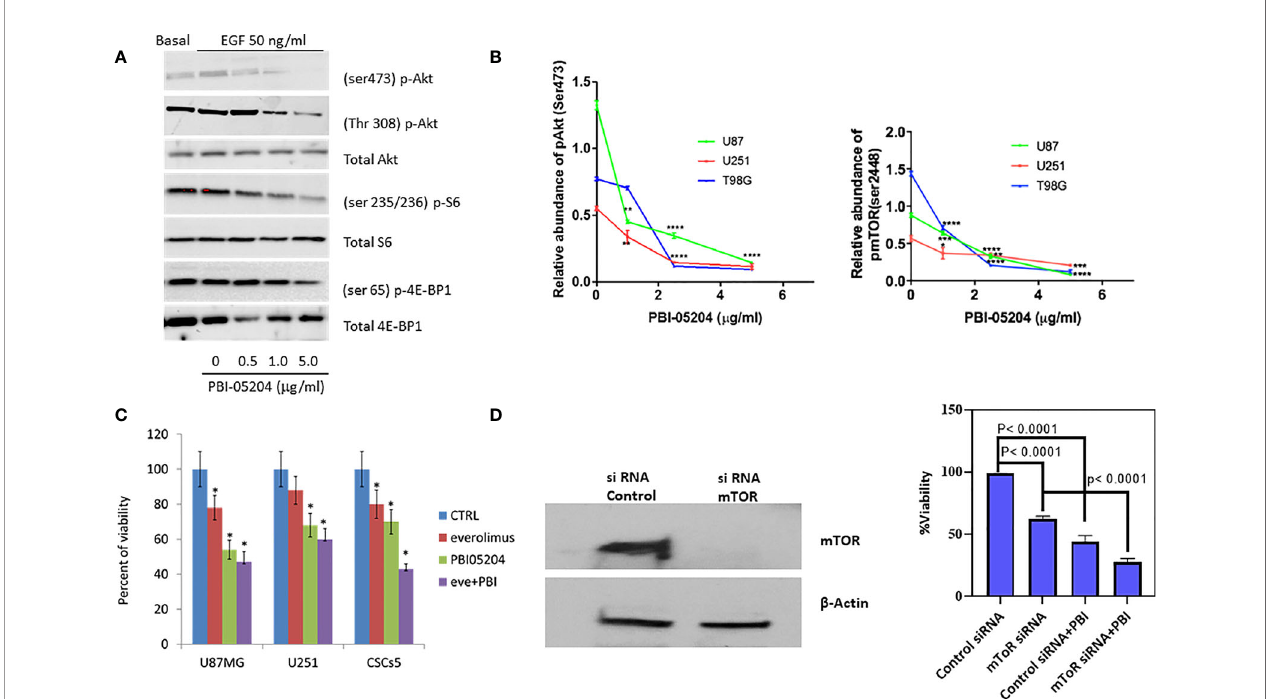
FIGURE 3 | PBI-05204 down-regulated PI3K/mTOR pathway in human GBM cells. (A) Western blots for p-Akt (Ser473), P-Akt (Thr308), p-S6 (Ser235/236), and p- 4E-BP1 (Ser65) proteins in EGF prestimulated U87MG cells after being treated with PBI-05204 for 72 h. (B) Quantitative analysis on the abundance of p-Akt (Ser473) and p-mTOR (Ser 2448) in PBI-05204 – treated GBM Cells. Experiments were performed in triplicate. (C) The growth of GBM cells treated with everolimus (50 ng/ml), PBI-05204 (2.5 m g/ml), and combination of everolimus and PBI-05204. (D) The expression of mTOR in control siRNA-transfected and mTOR siRNA – transfected U87MG cells. Data represent an experiment performed in quintuplicates. (E) The proliferation of control siRNA transfected and mTOR siRNA transfected U87MG cells treated with PBI-05204. Data are presented as mean ± SD. *p < 0.05, **p < 0.01, ***p < 0.001, ****p < 0.0001 versus